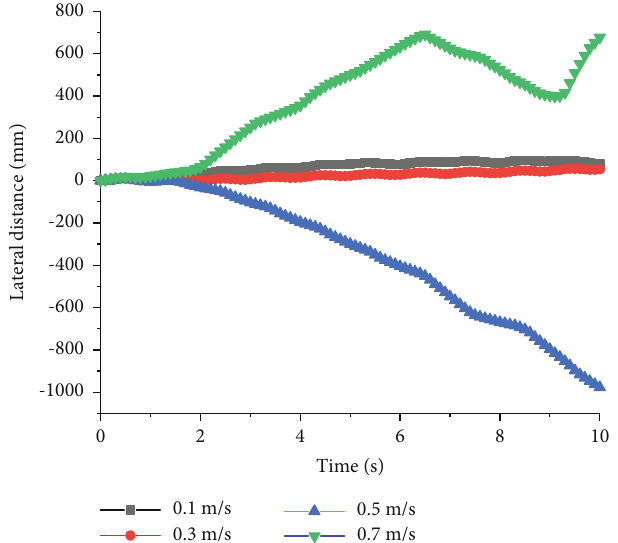
Figure 3: Lateral distance of quadruped robots with elbow joint for front legs and knee joint for back legs with di ff erent speed at a constant period.